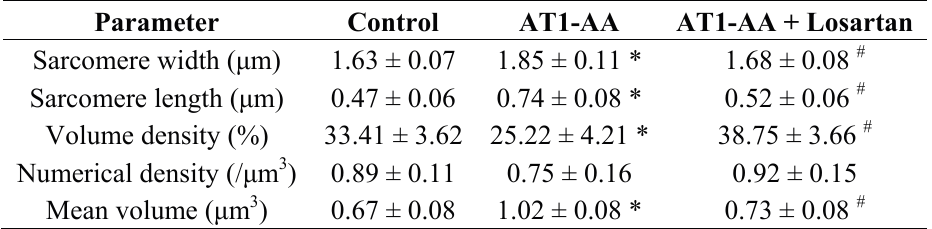
Table 4. Morphometric analysis of rat LV sarcomeres and